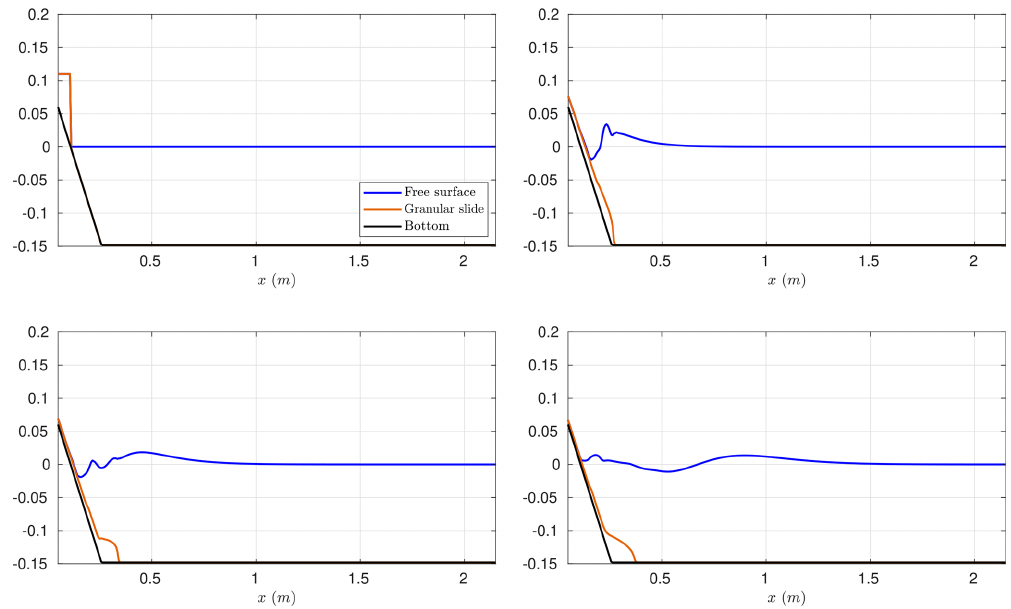
Figure 8. Modeled water free-surface elevation and granular slide location at times t = 0, 0.2, 0.4, and 0.8s for Case 1.